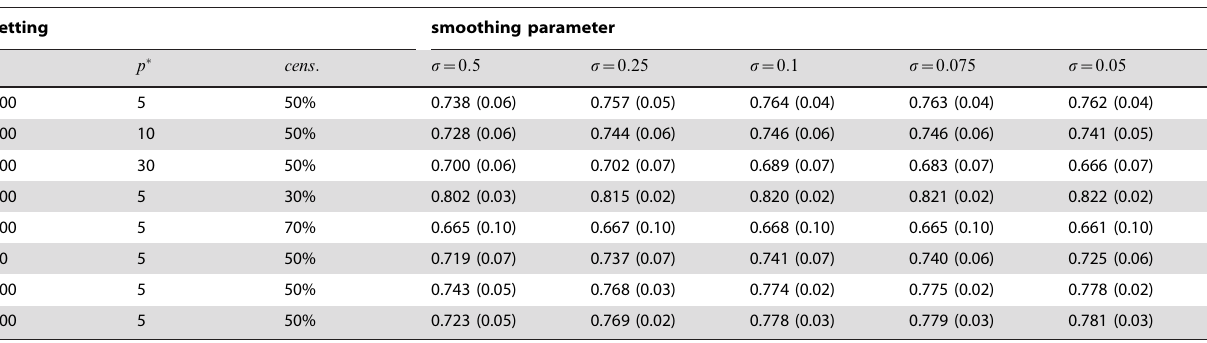
Table 2. Simulation results for different values of the smoothing parameter.